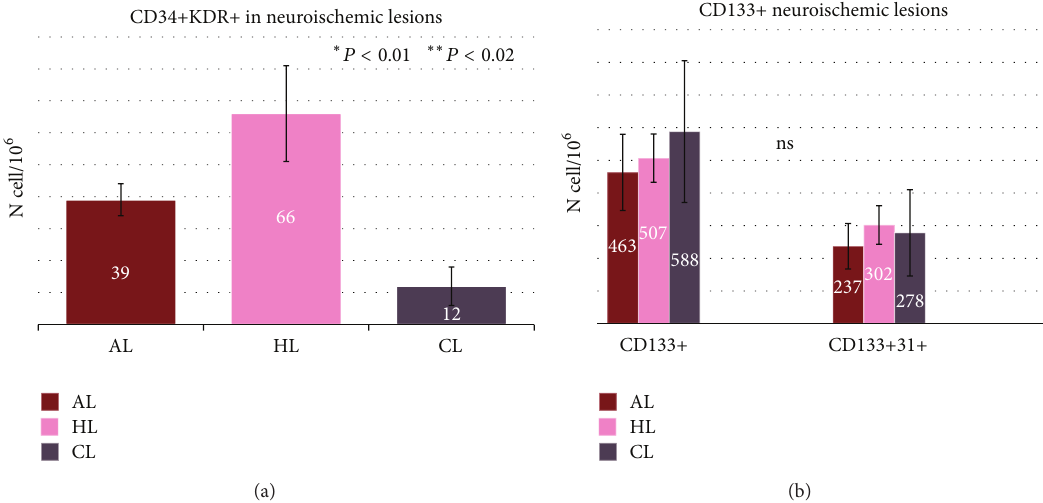
Figure 1: Levels of CD34+KDR+ (a) and CD133+ (b) progenitor cells in neuroischemic lesions in type 2 diabetic subjects depending of healing or not healing time course. AL acute lesions (brown), HL healed lesions (pink), and CL chronic lesions (grey). Units are N cells/10 6 ∗ 𝑃 < 0.01 AL versus CL ∗∗ 𝑃 < 0.02 HL versus CL.